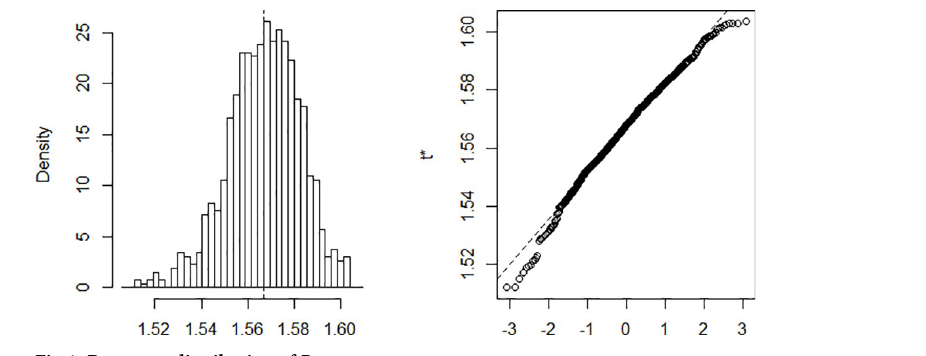
Fig 4. Bootstrap distribution of R 0 .